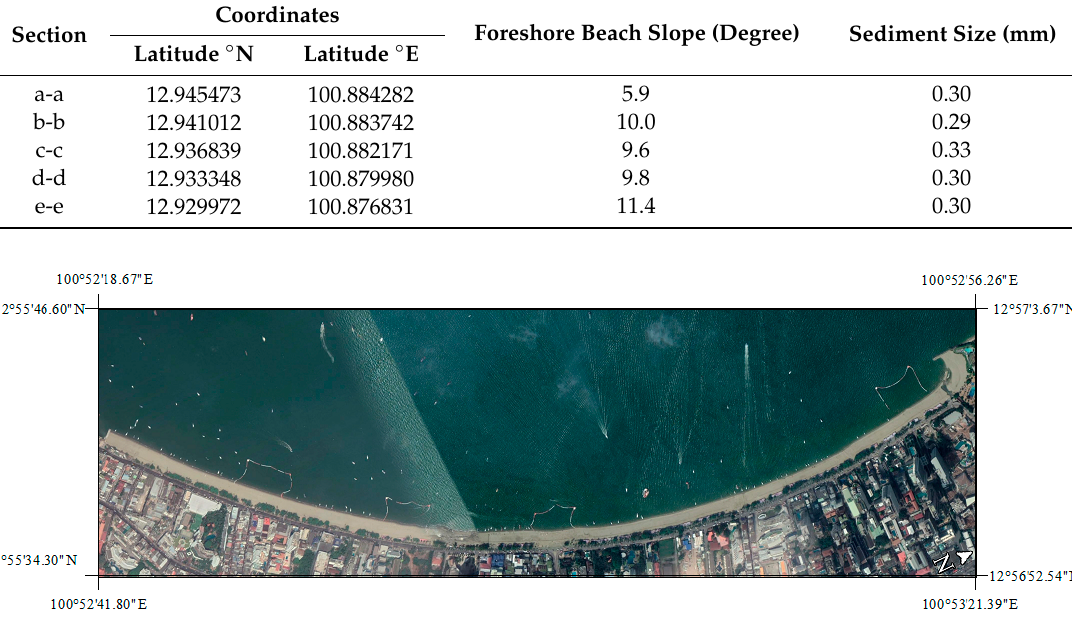
Figure 2. Survey sections of Pattaya beach. Table 3. Slope, sediment size of Chalatat Table 2. Slope, sediment size of Pattaya beach.